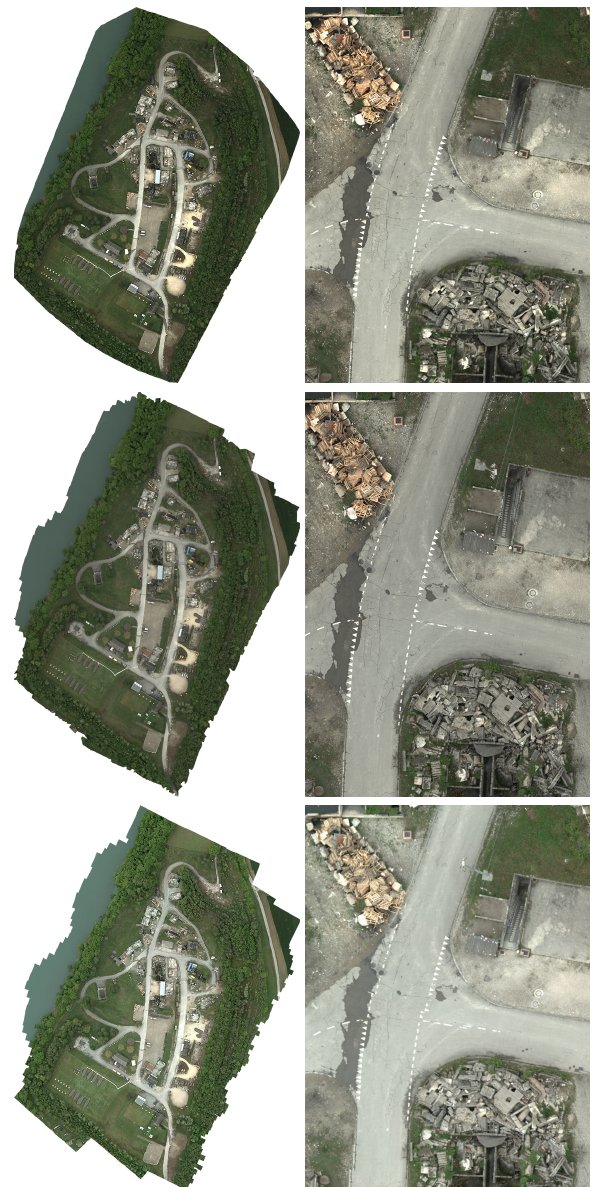
Figure 6. Rapid mapping with TAC algorithm for disaster man- agement: International rescue exercise ACHILLES 2017